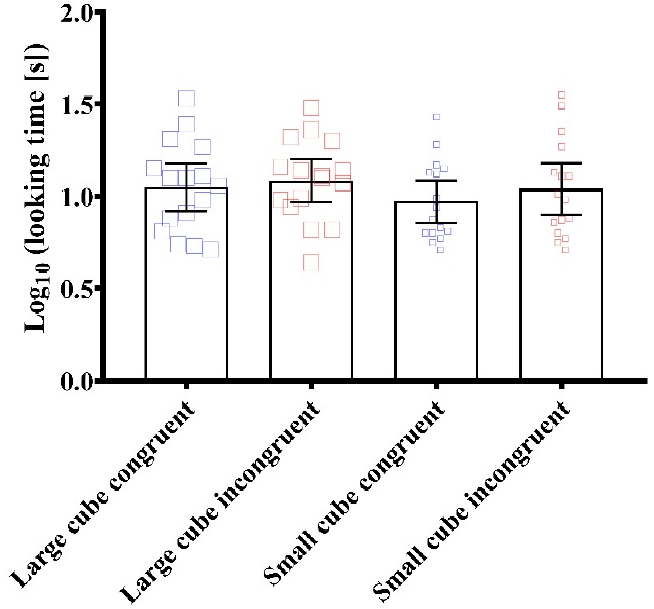
Figure 6. Looking time for small and large cube congruent and incongruent test events. Data are presented as grouped dot plots and mean and 95% confidence intervals. AU = arbitrary units.